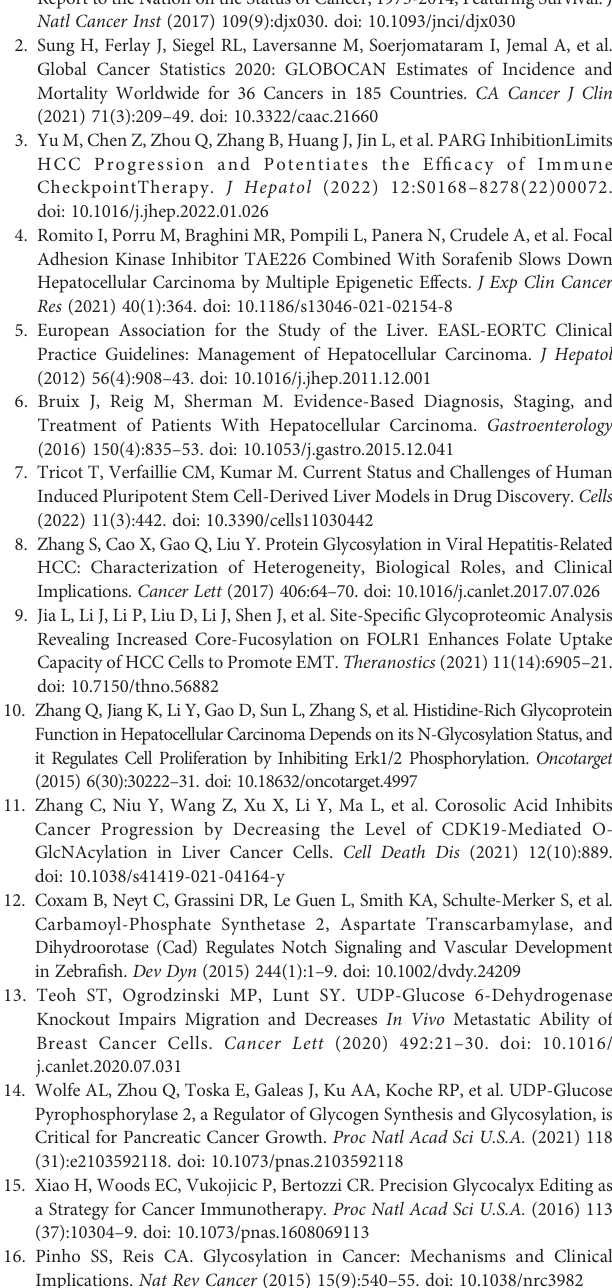
in fi ltration, and the glycosylation-based risk score. (B, C) Different relative proportions of immune cells in different groups. * P < 0.05; ** P < 0.01; *** P < 0.001. Supplementary Figure 5 | Validation of the prognostic signature in ICGC-LIRI- JP. (A) Kaplan-Meier curveanalysisofthelow-andhigh-riskgroups. (B) ROCcurve showing the prognostic risk model. (C) PCA plot of TCGA-LIHC patients in different risk groups. ROC, receiver operating characteristic; PCA, principal component